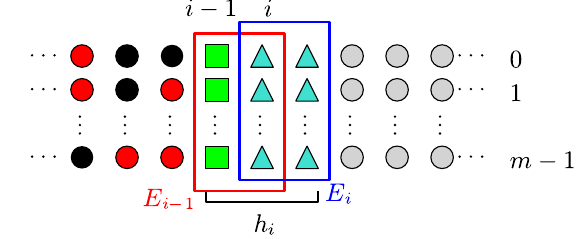
FIG. 1. The representation of the matrix M at the step where we compute E for an inequality with dichotomic measurements with i R ¼ 2 . The color (red or black) corresponds to the outcome assigned to that observable. At the i th step, an optimal local deterministic strategy for parties 0 to i − 2 is already set, and we are minimizing the local deterministic strategy at the ( i − 1 )th site (green squares). In order to perform the minimization, we need the values of the i th and ( i þ 1 )th parties to be fixed (blue triangles); i.e., we need to give a value to M ð i; 2 Þ . We check the 2 m possible values for the observables at site i − 1 and we find an optimal assignment for